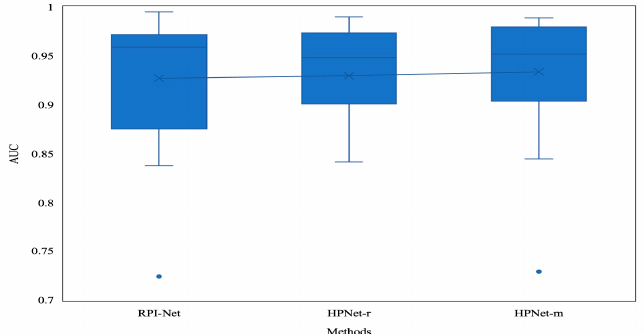
Figure 6. The performance comparison of the three methods with the debiased dataset.